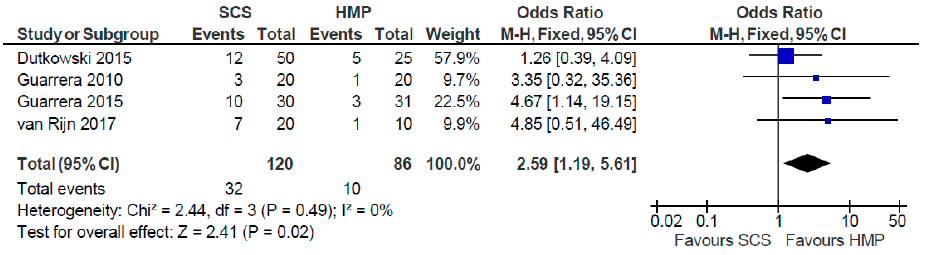
Figure 19. Post transplantation biliary stricture rates in studies comparing HMP to SCS.